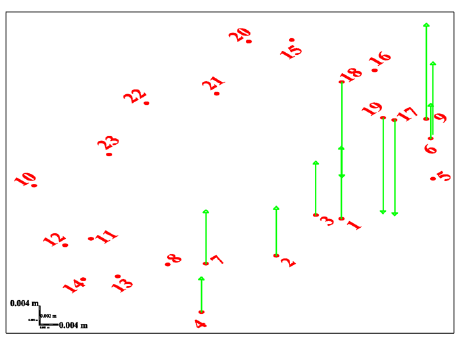
Figure 12. Vertical displacement vectors